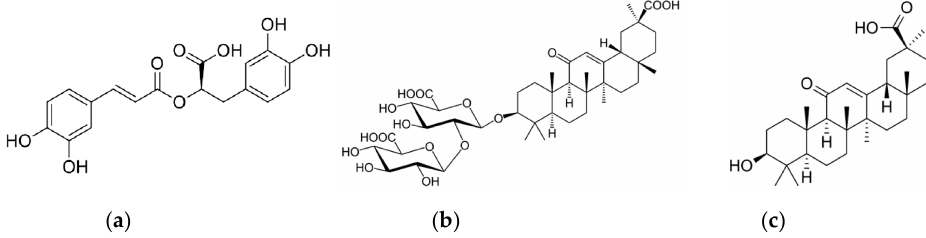
Figure 1. Chemical structure of rosmarinic acid ( a ), glycyrrhizic acid ( b ), and 18 β -glycyrrhetinic acid ( c ).